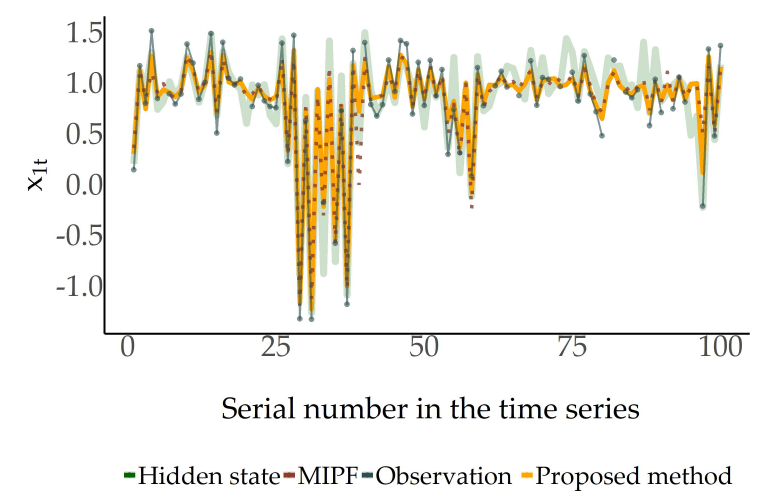
Figure 1. Time-series of the hidden values, the observations, and the corresponding point estimations of the proposed method and MIPF imputations for the first component x 1, t of the state process.